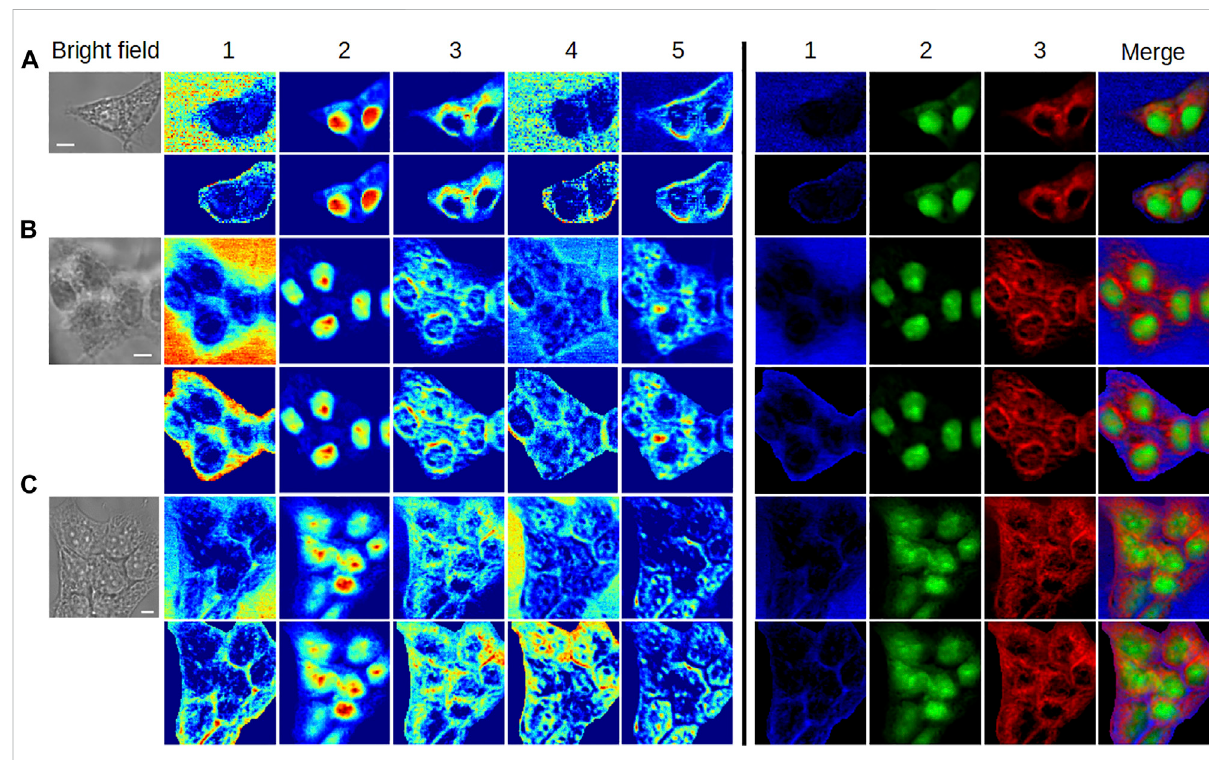
FIGURE 9 Application of MC 2 and MC 2,S approaches to the analysis of cell clusters. (A) 2-cell cluster, (B) 5-cell cluster, and (C) 8-cell cluster. For each cluster, the concentration maps computed by MC 2 and MC 2,S are plotted in fi rst and second rows, respectively, using two different colormaps. The scale bar corresponds to 5 μ m. The corresponding spectra are available in Supplementary